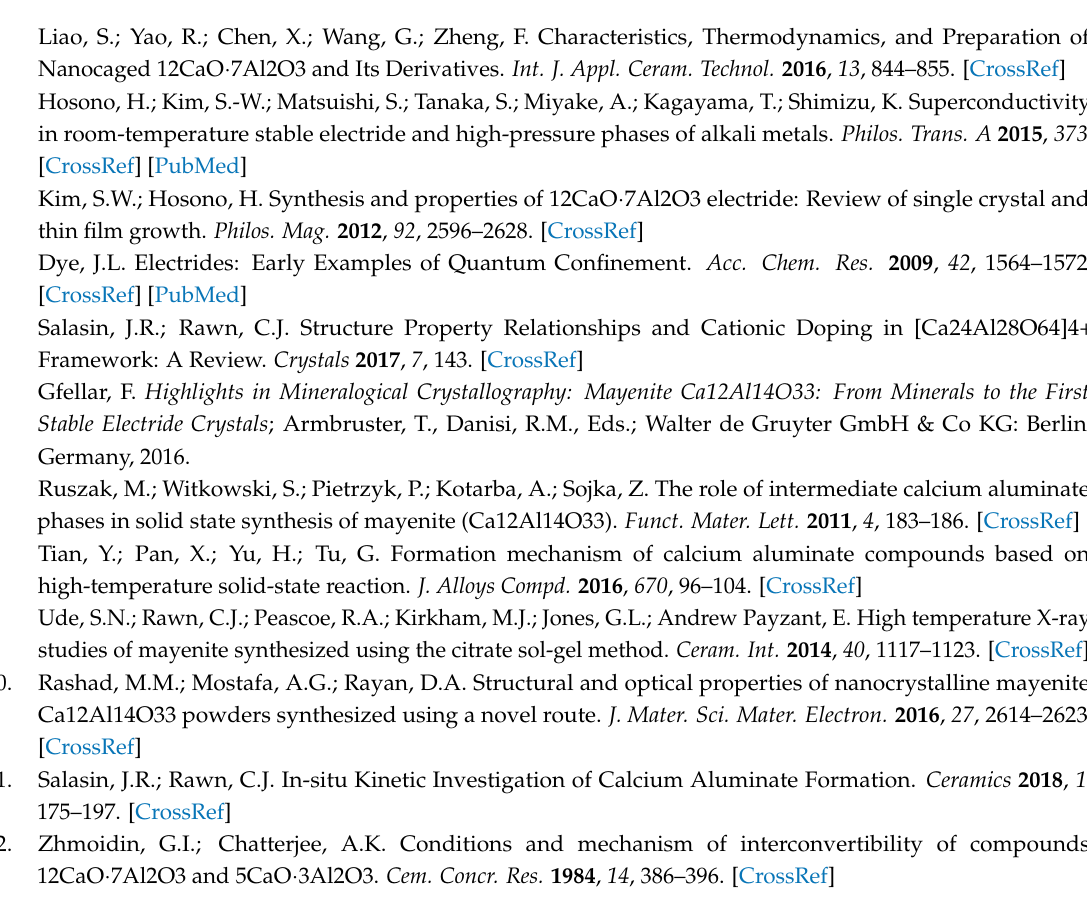
Figure S1: XRD patterns of HUP-processed oxy-C12A7 comparing the final characteristic structure after sintering at 1300 ◦ C for 2 h. The black process involved an additional step at 1200 ◦ C for 2 h prior to the 1300 ◦ C for 2 h. This was to allow for full decomposition of the C12A7 structure at 1200 ◦ C where oxy-C12A7 is unstable. Subtle changes in characteristic peaks were observed, indicating that both samples were primarily C12A7; however, when no hold at 1200 ◦ C was implemented, an increase in CA characteristic peaks at 30 ◦ 2 Θ was observed. Structural Rietveld refinement, detailed in the main text, indicates that a structural difference between the two samples is a significant indication that the electride formation rate was increased when the hold at 1200 ◦ C was